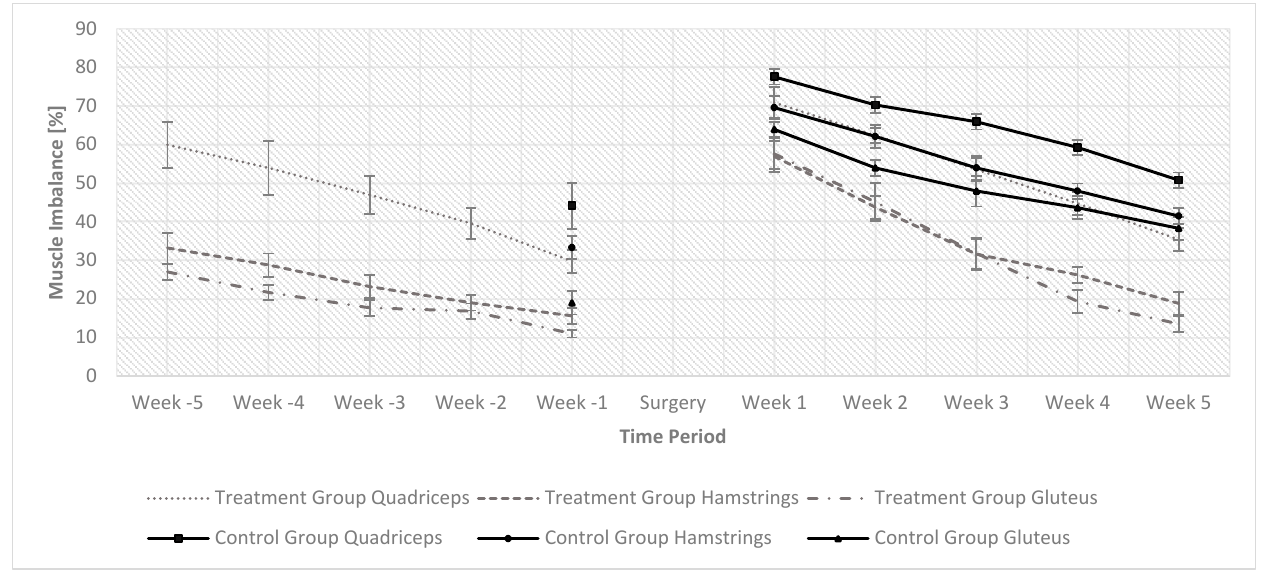
Figure 1. Time-course of muscle activity imbalance during pre- and post-operative phases of rehabilitation program.